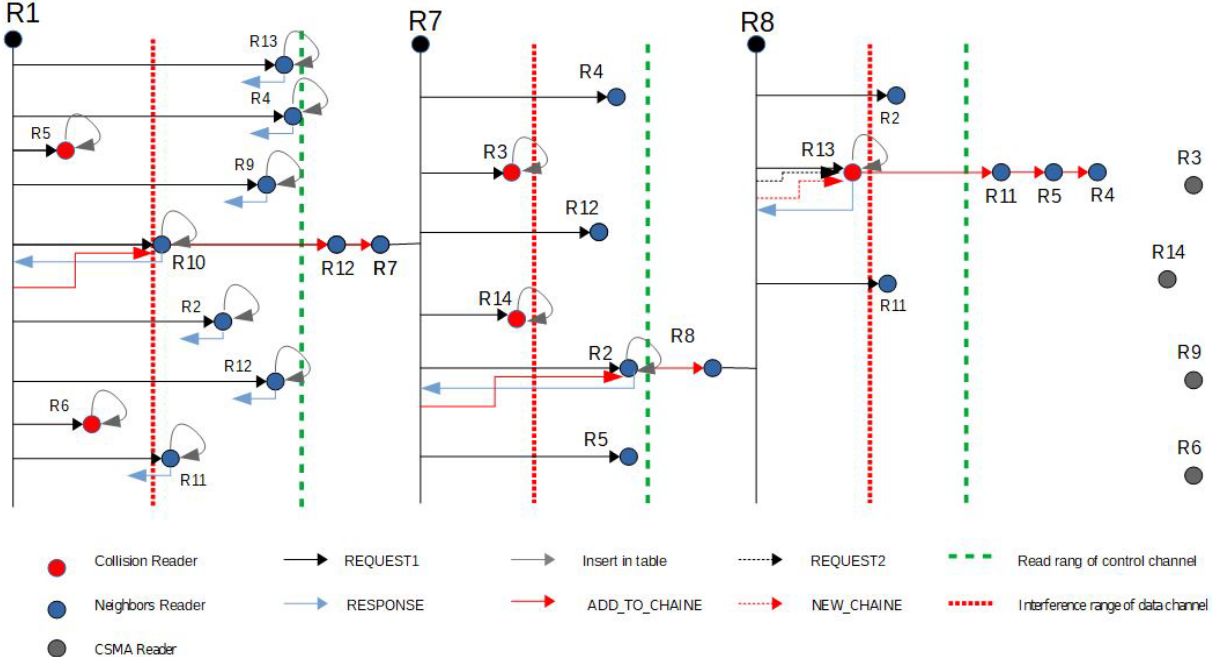
Figure 6. The process of creating FTDMA schemes .